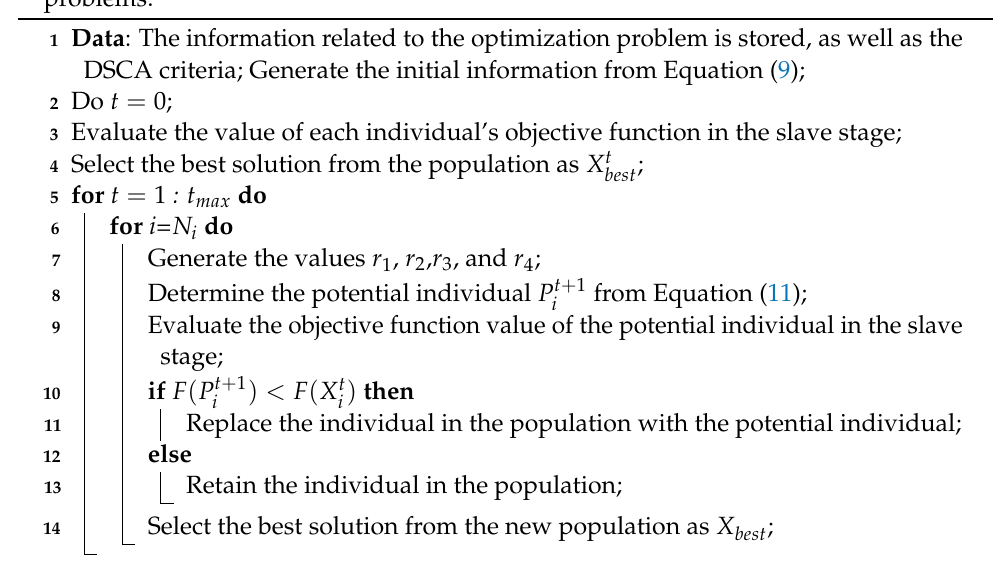
Algorithm 1: Pseudo-code for the proposed DSCA approach in optimization